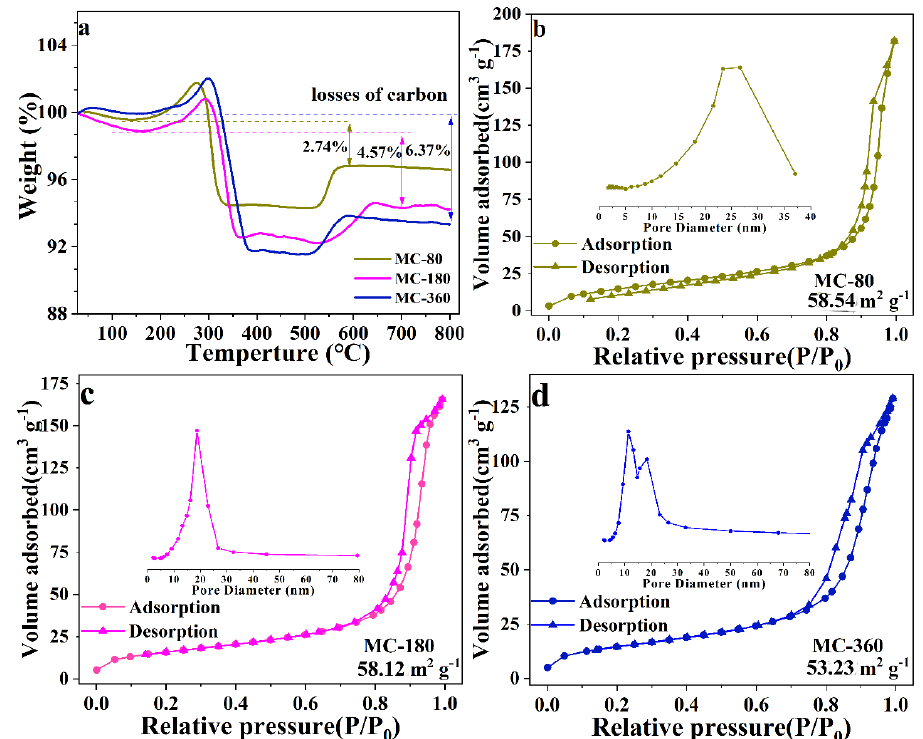
Figure 5. ( a ) TG (thermogravimetry) curves of MC-80, MC-180, and MC-360 (atmosphere: air, heating rate: 10 °C min − 1 ). ( b – d ) N 2 adsorption-desorption isotherms of MC-80, MC-180, and MC-360, and the inset figures are corresponding size distribution curves.